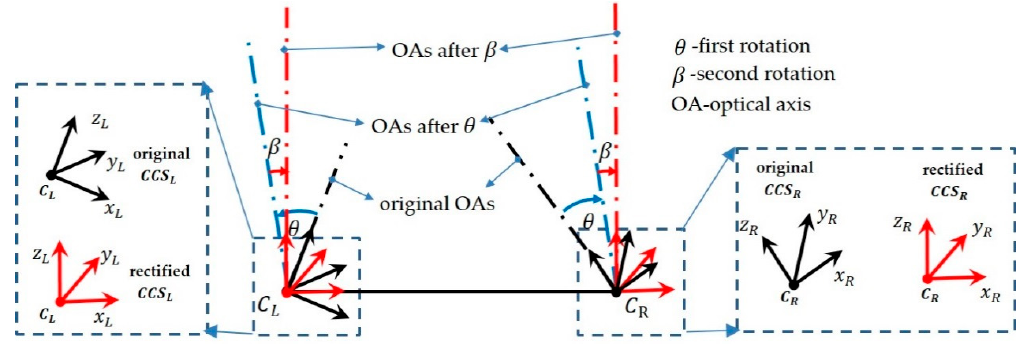
Figure 5. Stereo rectification by two rotations. CCS: camera coordinate system.